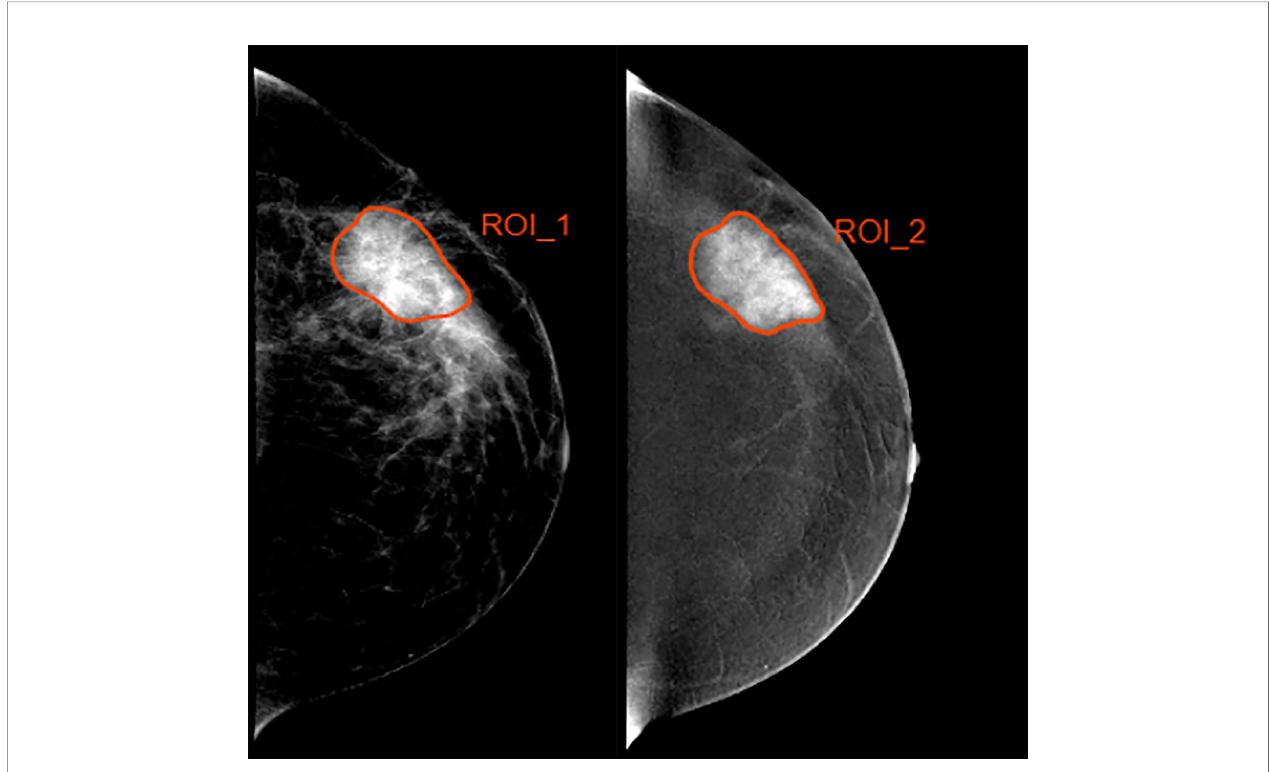
FIGURE 1 | Example of delineating region of interest (ROI) in a 35 year-old woman with a 4.5-cm mass in the left breast. (Left) The low-energy and (Right) recombined images with cranial caudal (CC)